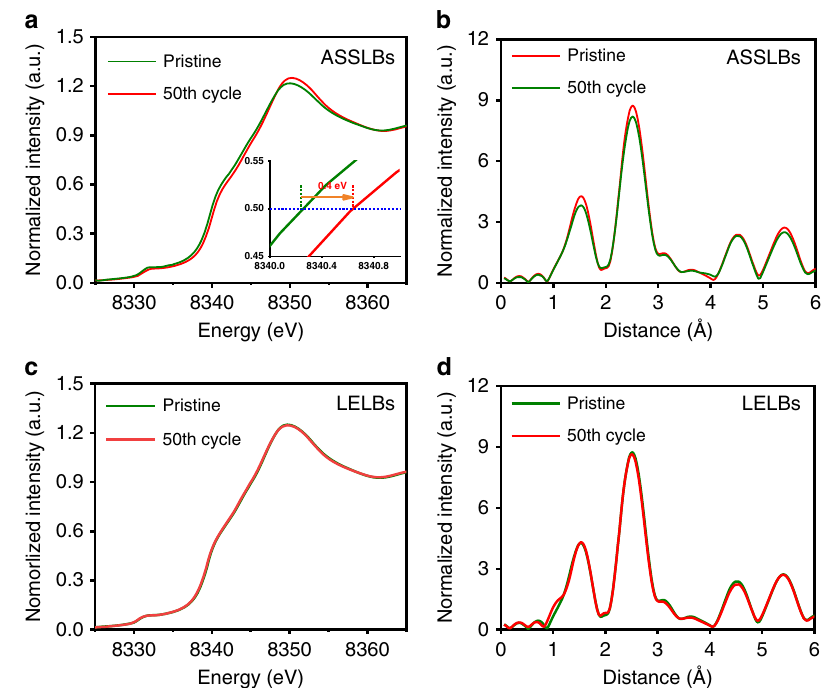
Fig. 5 Evolution of chemistry information of cycled NCM cathodes in the ASSLBs and LELBs. XANES and EXAFS of the pristine electrodes and cycled electrodes after 50 cycling ( a , b ) in the ASSLBs, and ( c , d ) in the LELBs.